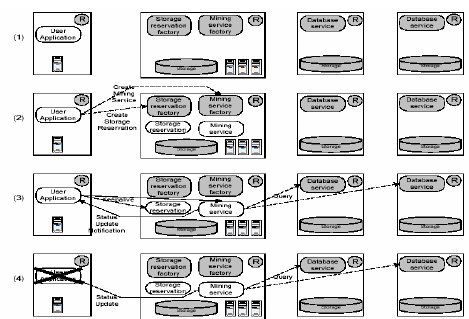
Figure 11: An example of Grid services at work. [1] World Wide Web The ubiquity of Web technologies (i.e., IETF and W3C standard protocols —TCP/IP, HTTP, SOAP,